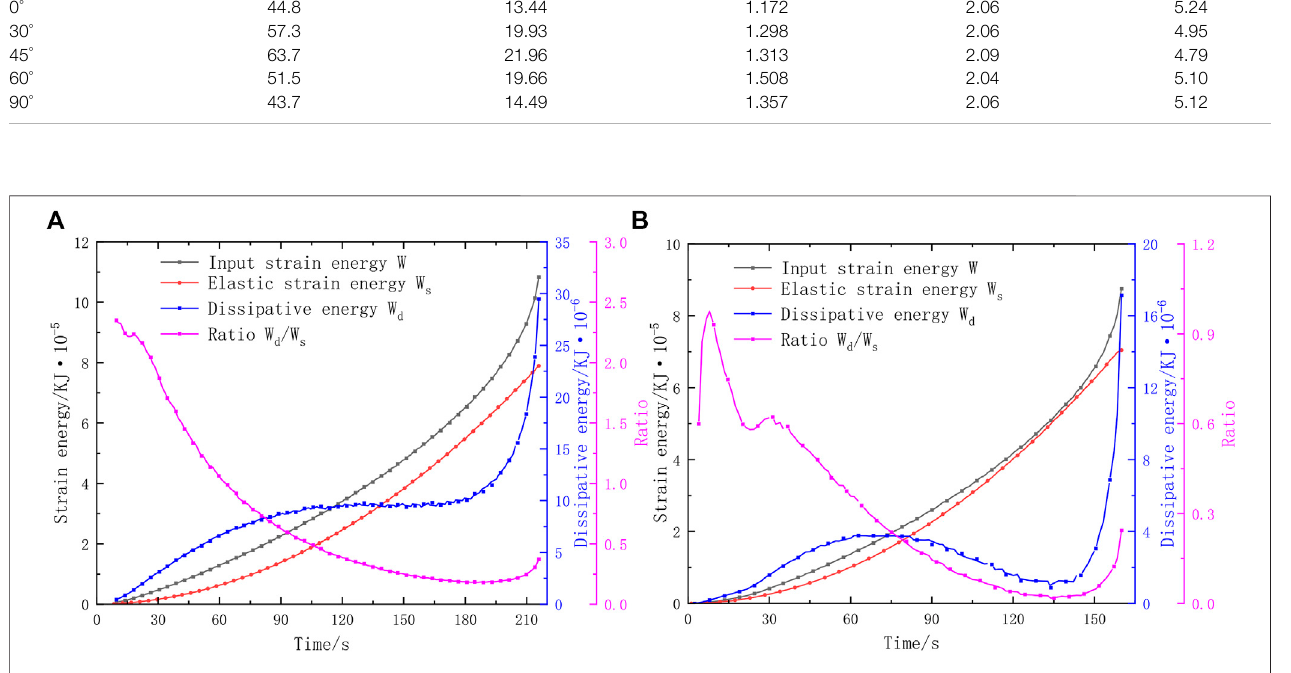
Frontiers in Earth Science |